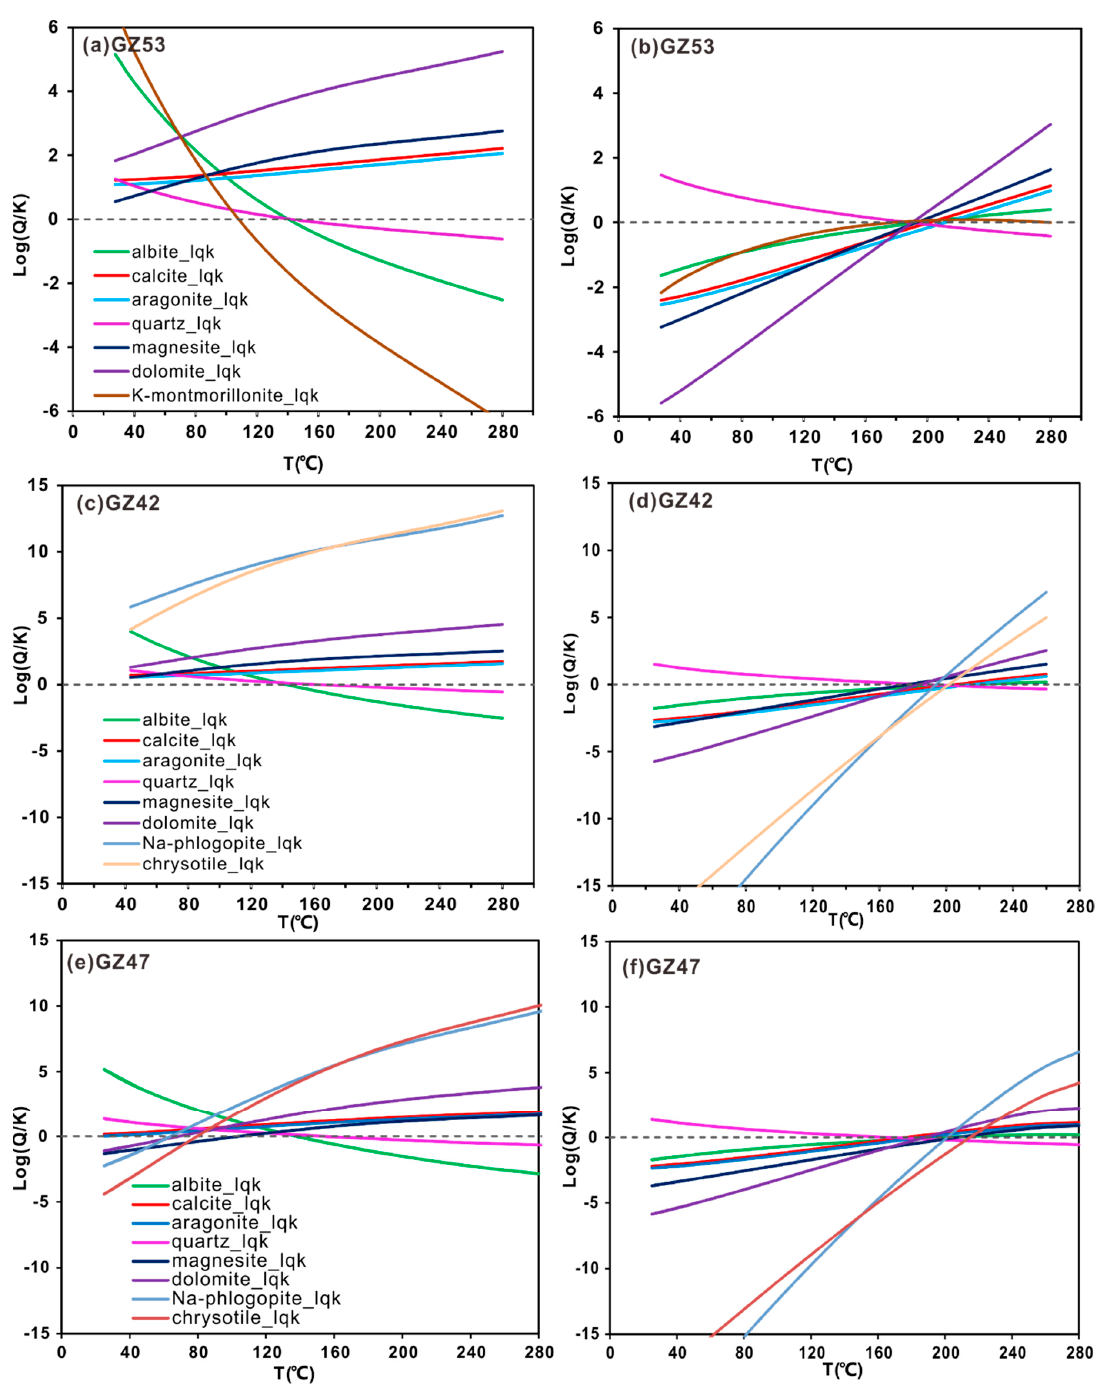
Figure 13. Variation in temperature with Log(Q / K) values of minerals for the original water samples ( a ) GZ53, ( c ) GZ42, ( e ) GZ47. Variation in temperature with Log(Q / K) values of minerals corrected for CO 2 degassing for original water samples ( b ) GZ53, ( d ) GZ42, ( f ) GZ47. For discussions on methodology, see Pang and Reed, 1998 [79].